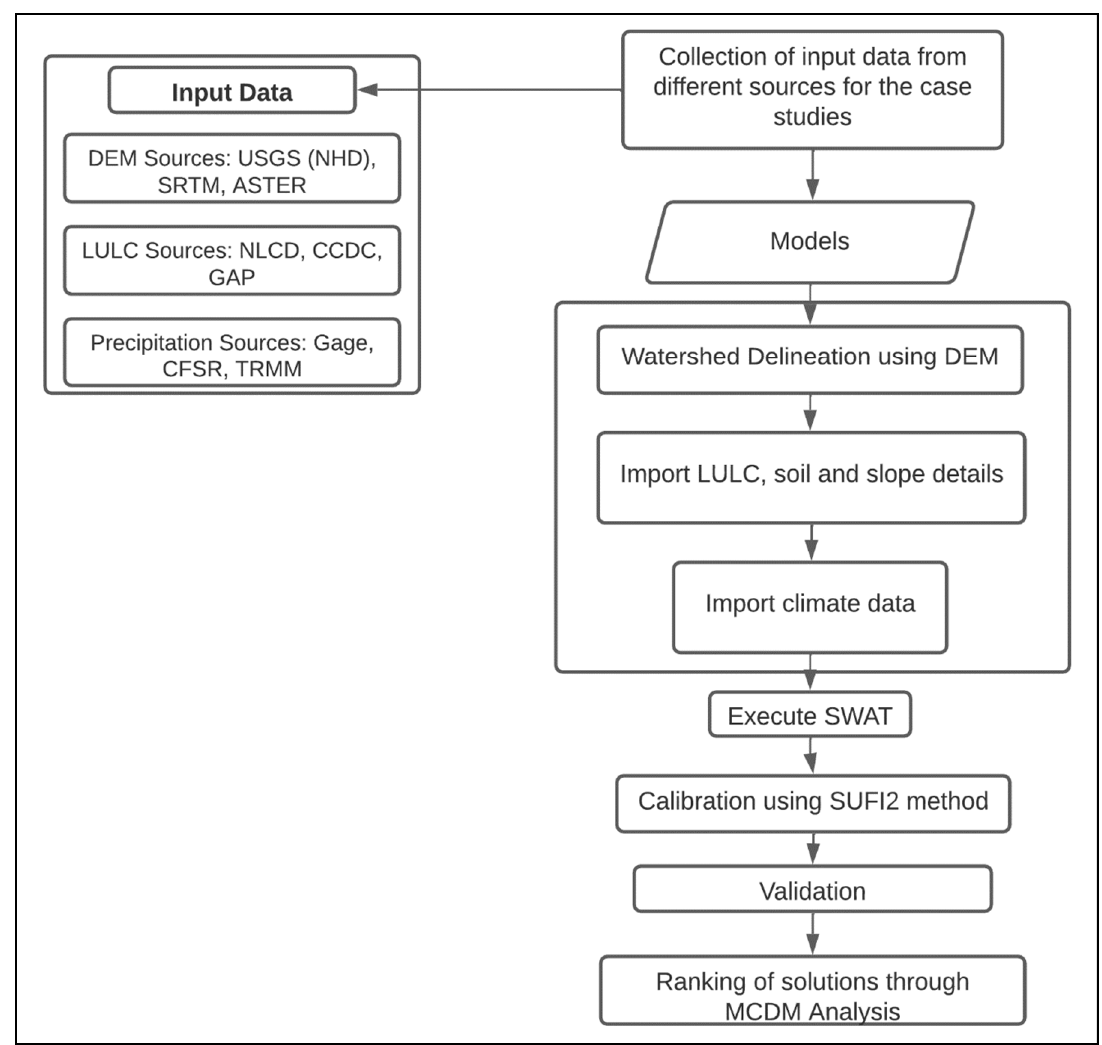
Figure 1. Hydrological modelling framework used to carry out the uncertainty analysis in the prediction of streamflows.